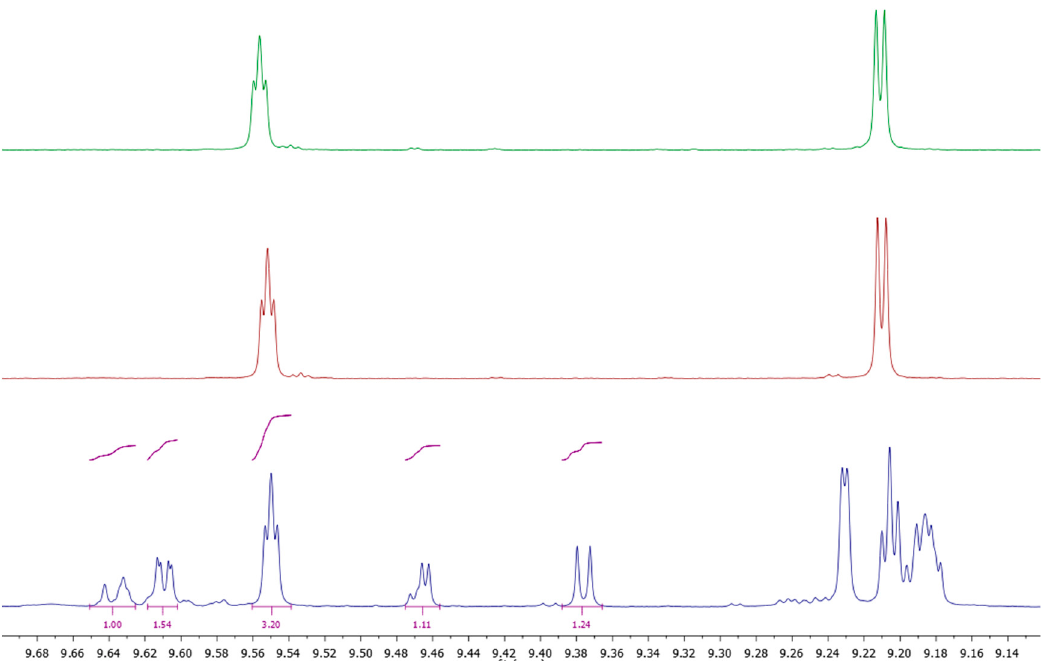
Figure 5. 1 H-NMR spectra (400 MHz, CD 3 CN, aldehyde region) from top to bottom: Decarboxymethyl oleuropein aglycone dialdehyde form (oleacein), decarboxymethyl ligstroside aglycone dialdehyde form (oleocanthal), sample S-26. Table 6. Total Htyr and Tyr (free and bound forms) content (mg/20 g oil) of VOO samples according to protocol F.